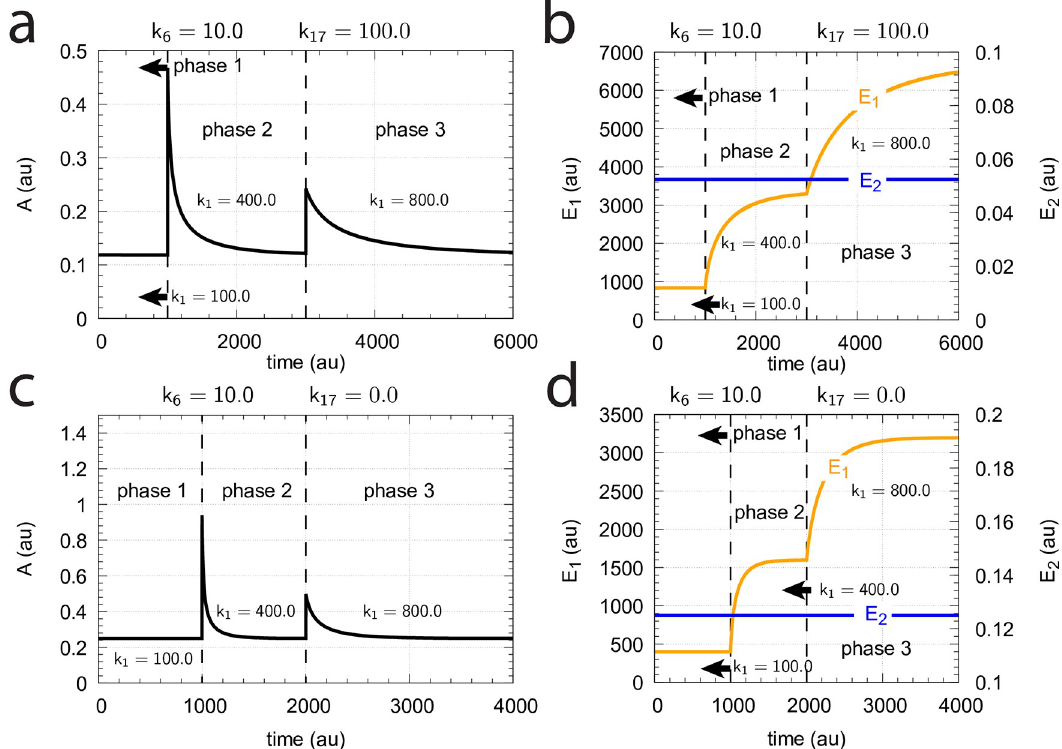
Fig 46. Demonstration of homeostatic behavior in A (Fig 45) when k 6 =10.0 and k 17 =100.0 (panels a and b) or k 17 =0.0 (panel c and d). Step-wise perturbations are applied with values k 1 =100 (phase 1), k 1 =400 (phase 2), and k 1 =800 (phase 3). Other rate constants as in Fig 45. Initial concentrations, (a) and (b): A 0 =0.1189, E 1,0 =8.40 × 10 2 , E 2,0 =5.25 × 10 − 2 , Ez 0 =5.66 × 10 − 11 , (E 1 � Ez) 0 =4.75 × 10 − 8 , 10 8 � 10 (cid:0) 6 k 7 k 7 Ez tot (Ez � � E 2 ) 0 =4.75 × 10 − 8 , and f ¼ 1 : 25 =9.05 × 10 − 7 . Initial concentrations, (c) and ¼ þ 1 ¼ 2 : 0 ) A ¼ ¼ ss set 2 � 40 : 0 k 11 k 5 � f ss (d): A 0 =0.25, E 1,0 =3.99 × 10 2 , E 2,0 =1.25 × 10 − 1 , Ez 0 =2.51 × 10 − 10 , (E 1 � Ez) 0 =1.00 × 10 − 7 , (Ez � � E 2 ) 0 =1.00 × 10 − 7 , and Ez �